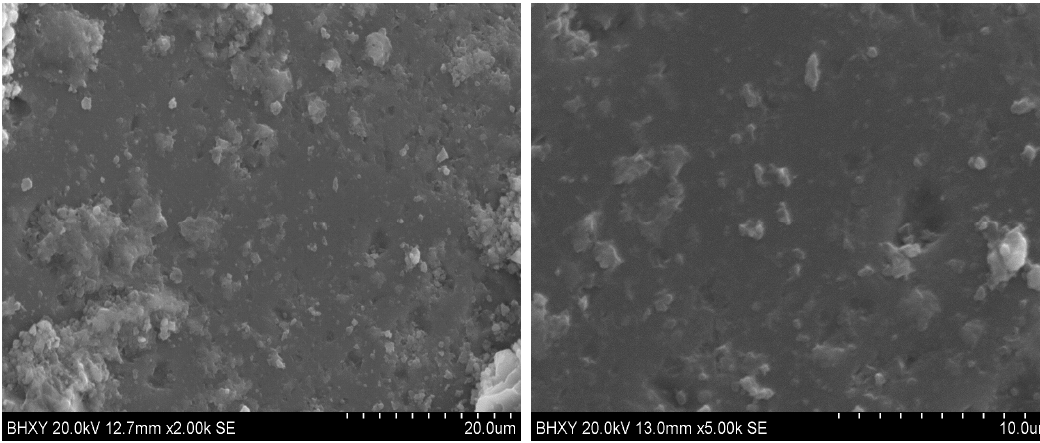
Figure 13. Scanning electron microscopy (SEM) images of green WGS-blended mortar matrix under 2K and 5K magnifications.